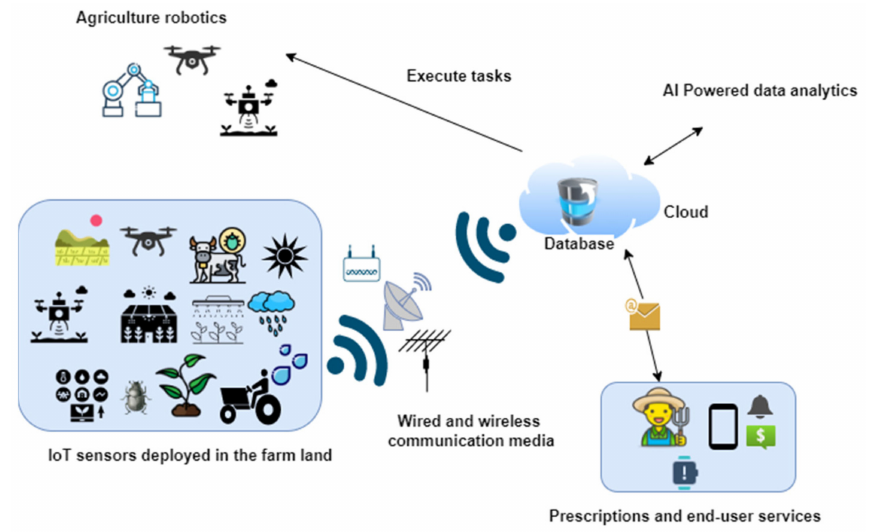
Figure 2. Overall steps in precision